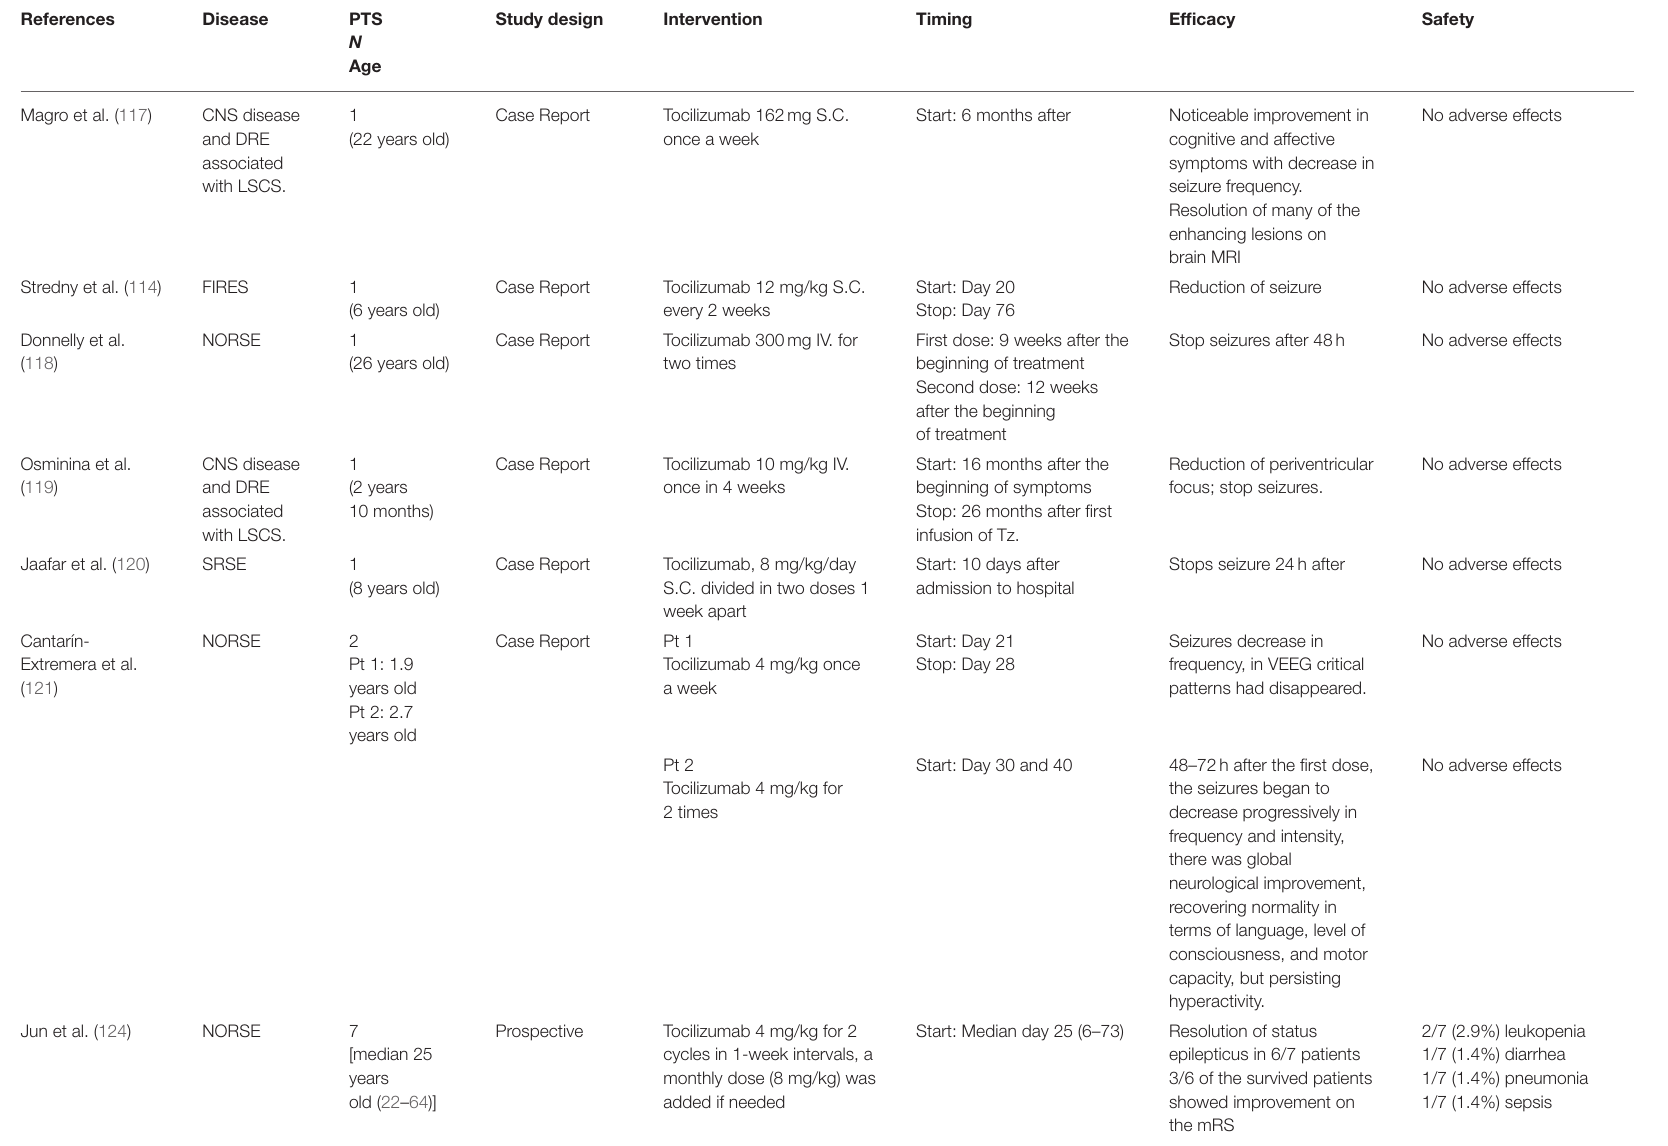
TABLE 3 | Systematic review of anti-IL-6 agents in